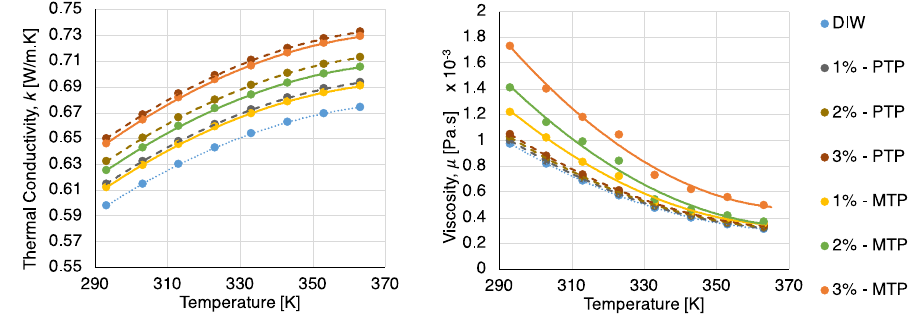
Figure 3. Measured and predicted temperature-dependent thermal conductivity and viscosity values for working fluids. Both data points and polynomial fits (dashed lines for PTP, solid lines for MTP) are given in the figure.